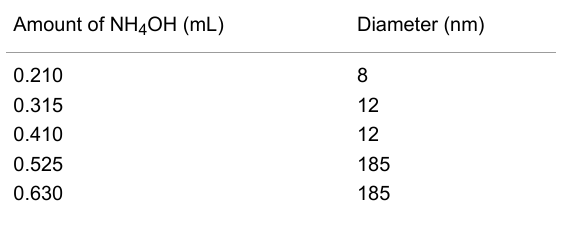
Table 4: Diameter of tin dioxide particles as a function of the amount of precipitant (ammonium